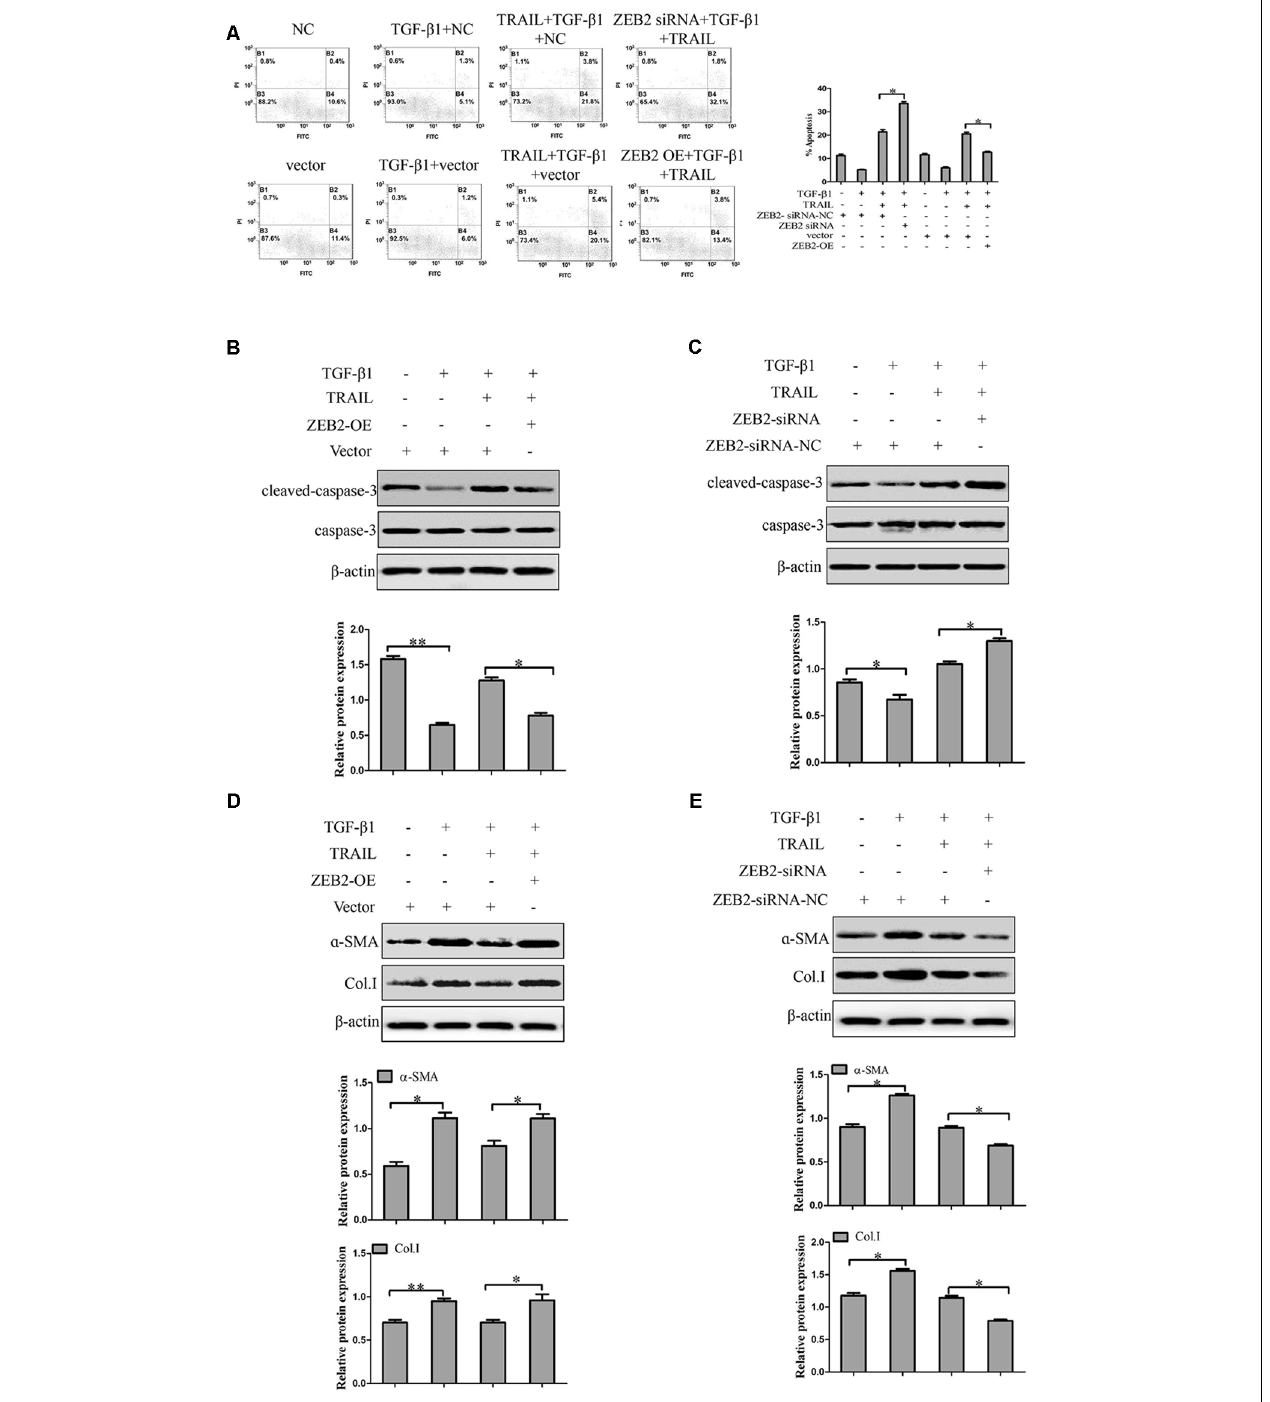
FIGURE 6 | The effect of ZEB2 on TRAIL-induced apoptosis of LX-2 cells. (A) The LX-2 cells were transfected with ZEB2-siRNA and ZEB2-OE, respectively that were pretreated with TRAIL (10 ng/ml) for 24 h, and then apoptotic rate of LX-2 cells were measured by flow cytometry. (B) The LX-2 cells were transfected with ZEB2-OE that were pretreated with TRAIL (10 ng/ml) for 24 h, and then protein level of cleaved of caspase-3 was measured by Western blot. (C) The LX-2 cells were transfected with ZEB2-siRNA, and then protein level of cleaved of caspase-3 was measured by Western blot analysis. (D,E) The LX-2 cells were transfected with ZEB2-siRNA and ZEB2-OE, respectively, and then level of α -SMA and Col. I was detected by Western blot analysis. The assays were performed at least three times with similar results. Data are shown as the mean ± SD ( n = 3) of one representative experiment. ∗ p < 0.05, ∗∗ p < 0.01 versus normal groups.